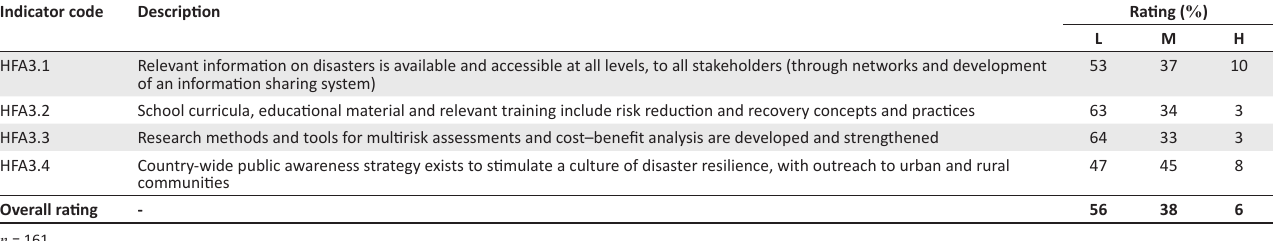
TABLE 4: Perceptions of respondents with regard to achieving Hyogo Framework for Action 3: Use knowledge, innovation and education to build resilience. Indicator code